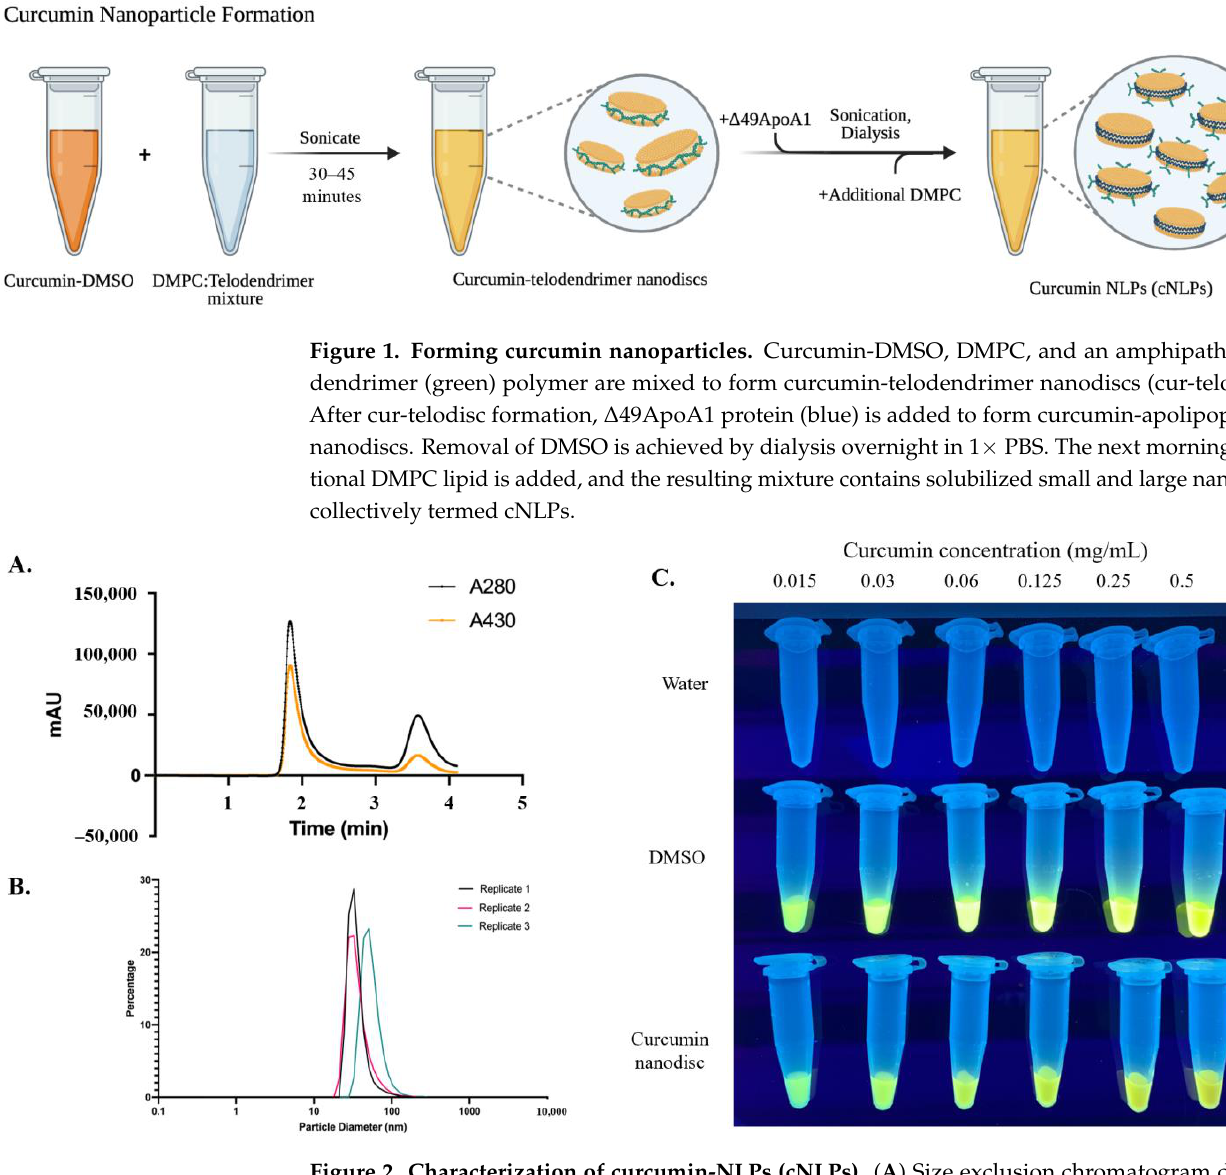
Figure 2. Characterization of curcumin-NLPs (cNLPs). ( A ) Size exclusion chromatogram demon- strates that curcumin associates within larger (leftmost peak) as well as smaller (rightmost peak) ApoA1-NLPs via co-localized 280 nm protein absorbance (black) and 430 nm curcumin absorbance (orange). ( B ) Dynamic Light Scattering of cNLPs demonstrates that these particles average about 43 nm in diameter. ( C ) Comparison of curcumin fluorescence when solubilized in water, DMSO, or curcumin-telodendrimer nanodiscs at 0.015 – 0.5 mg/mL concentrations. 3.2. Normal Human Fibroblasts Tolerate cNLPs Better than DMSO-Solubilized